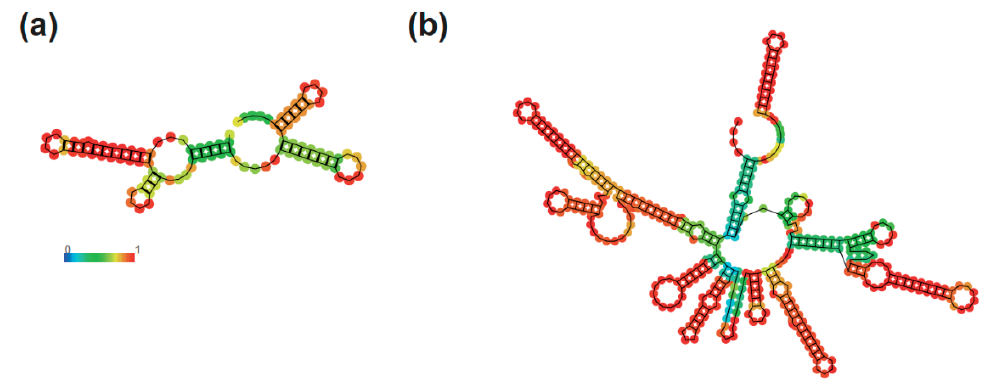
Figure 2. Secondary structure of the untranslated regions from the Zika virus genome assembled. Analysis of the secondary structure of ( a ) 3 (cid:48) and ( b ) 5 (cid:48) UTR of Zika virus genome.